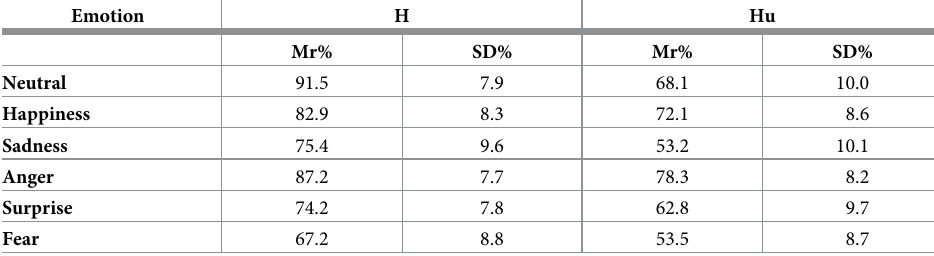
Table 7. Raw hit rates (H) and unbiased hit rates (Hu) for emotion categories: Phase 2.